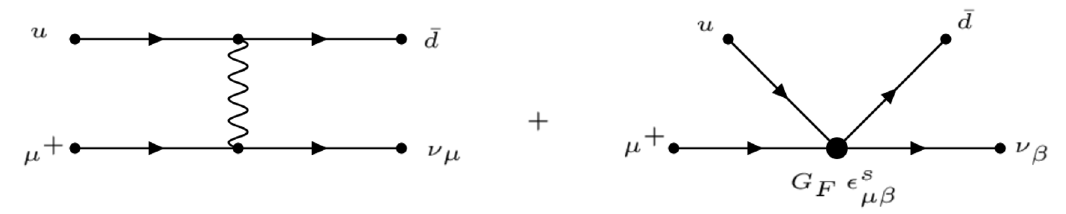
Figure 2 . An illustration of the non-standard interactions in the neutrino source. A positively charged pion decays incoherently into a positive muon and a muon neutrino or a different fla- vor